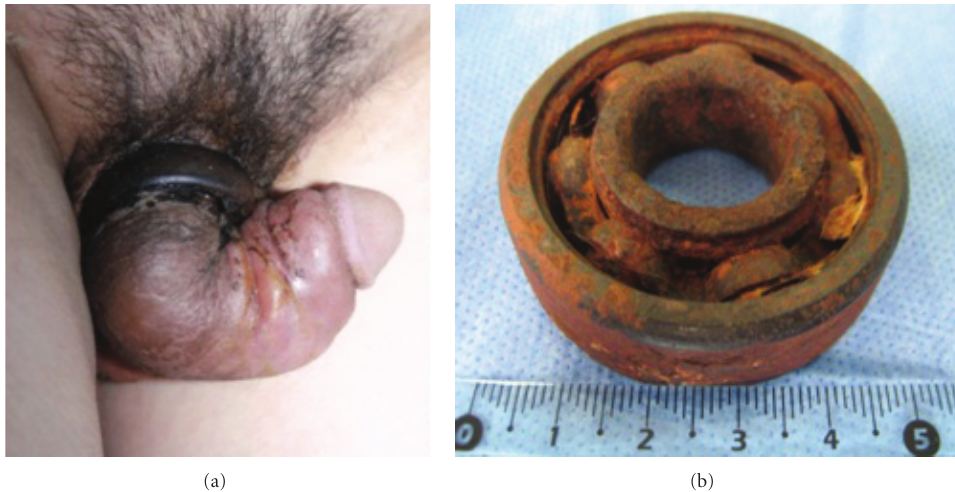
Figure 1: (a) Axletree strangulated to the penoscrotal junction; (b) removed